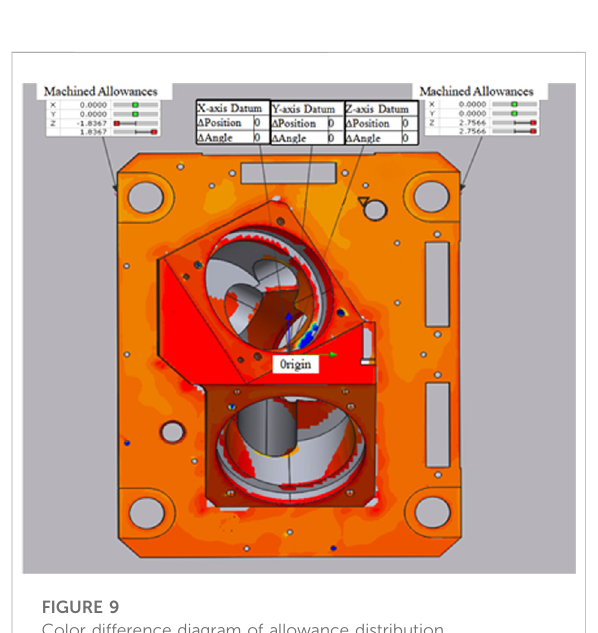
FIGURE 9 Color difference diagram of allowance distribution.